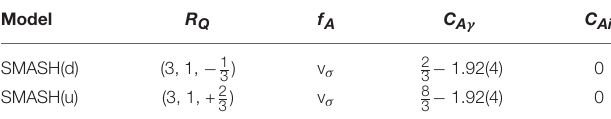
TABLE 1 | Axion predictions for two SMASH variants exploiting distinct vector-like quarks transforming as R Q under the SM gauge group